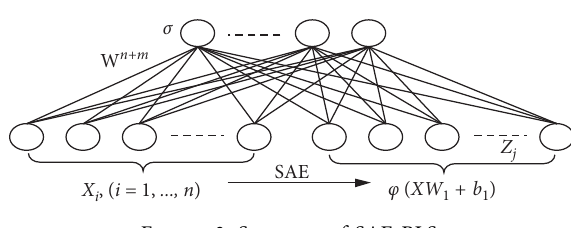
Figure 3: Structure of